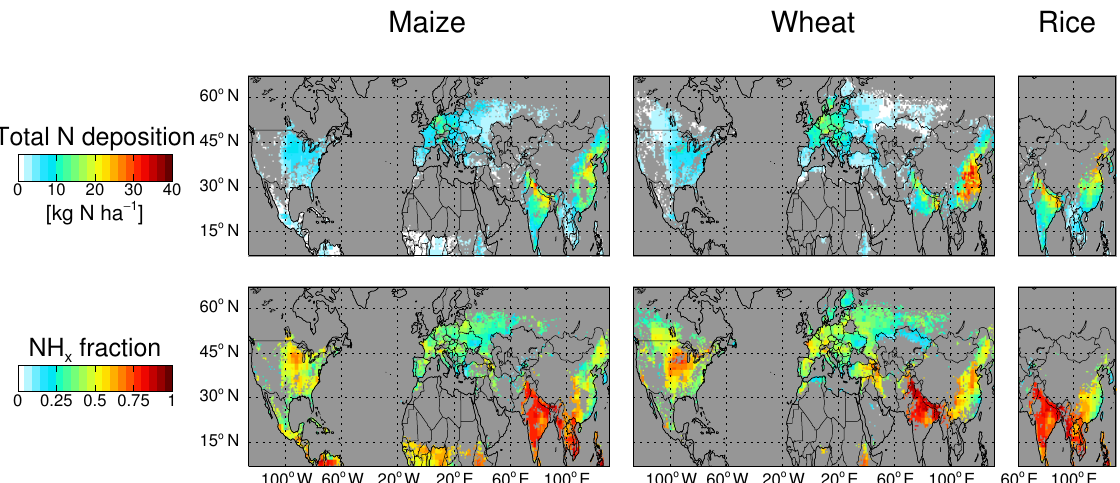
Figure 6. Total nitrogen (N) deposition from GEOS-Chem (top row panels) and reduced nitrogen (NH x ) fraction of this total (bottom row panels). For pDSSAT growing season (determined by the base simulation) ending in 2010 for maize (left column panels), wheat (middle column panels), and rice (right column panels). Filtered for GAEZ base crop production greater than 0.01Mgkm − 2